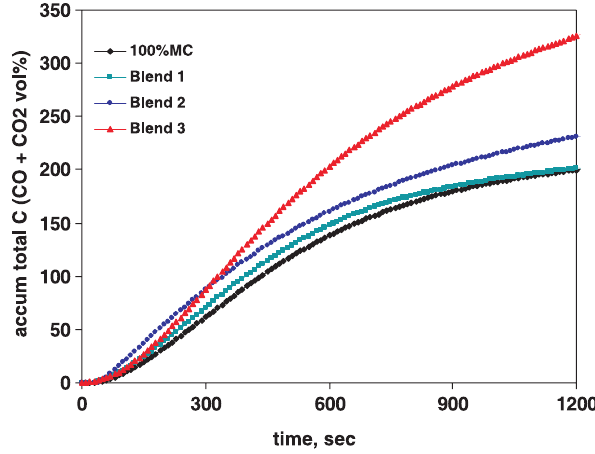
Fig. 4: Off gas generation as a result of coke/rubber blends-slag reactions in EAF